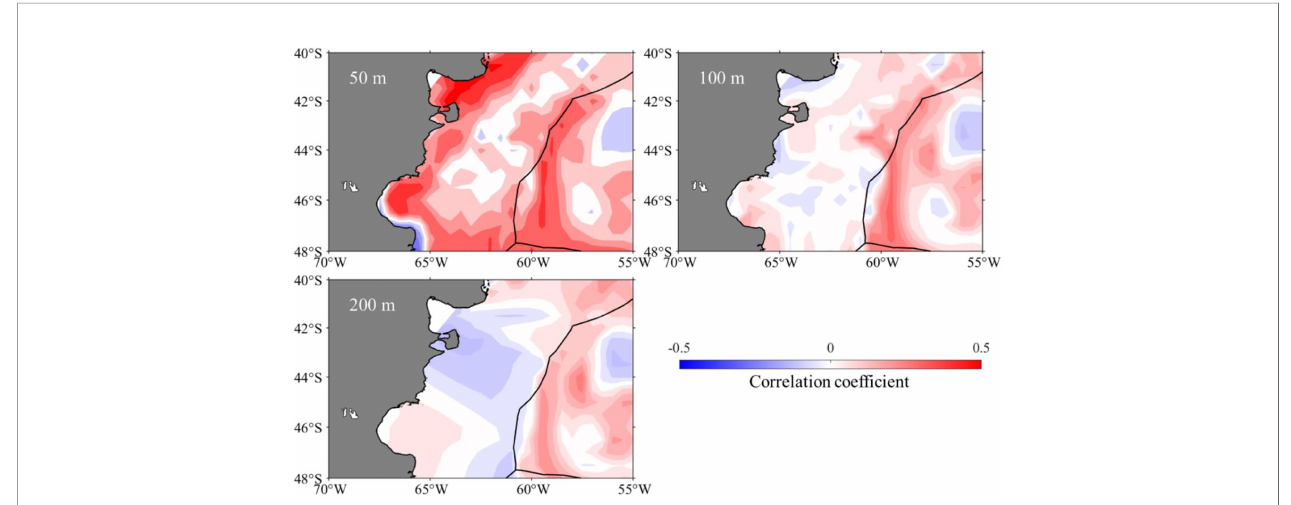
FIGURE 4 | Spatial distribution of correlation coef fi cient between sea water temperature at depths of 50, 100, and 200 m and sea ice extent from 1979 to 2017 on the fi shing ground in the high seas of Southwest Atlantic